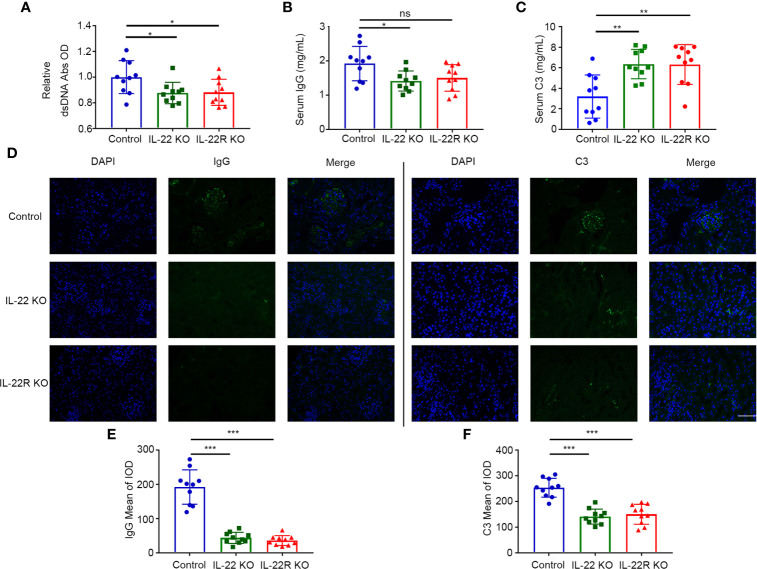
IL-22 or IL-22R deficiency altered the levels of autoantibody and complement in lupus-prone mice. (A–C) The level of serum dsDNA Abs, total IgG and C3 were measured by ELISA in 24-weeks-old control, IL-22 KO and IL-22R KO mice. (D) Representative photos of IgG and C3 deposition in the glomeruli of 24-weeks-old control, IL-22 KO and IL-22R (scale bar, 50 μm). (E, F) Quantification of the mean IOD of IgG and C3 per glomerular cross-section in all groups of mice. Data were expressed as mean ± SD, and are representative of three independent experiments. One way ANOVA was used for comparison among all groups (*P < 0.05, **P < 0.01, ***P < 0.001).